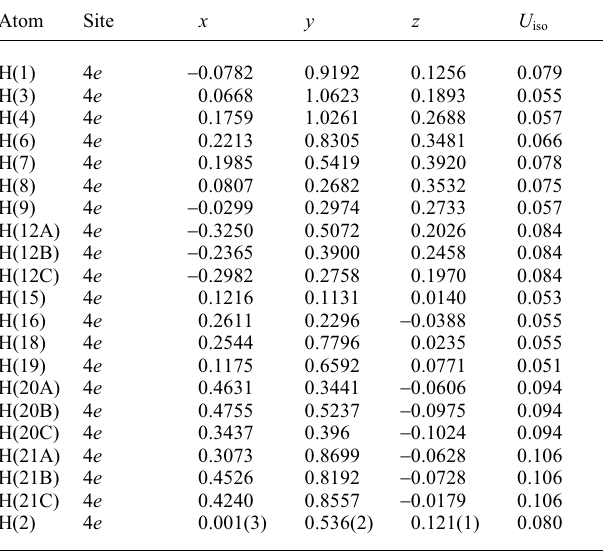
Table 2. Atomic coordinates and displacement parameters (in Å 2 )